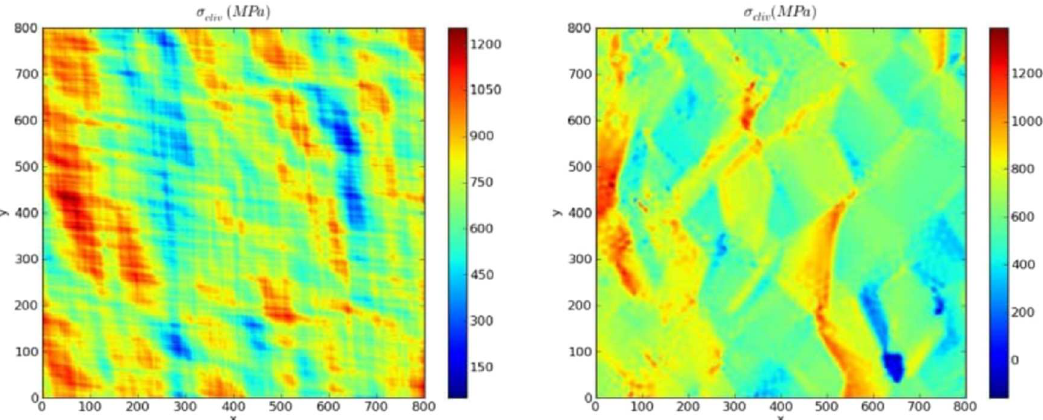
Fig. 3. Simulation of a stress field using the identified periodogram (left) and a FEM output utilized as the training image for the left one – extracted from